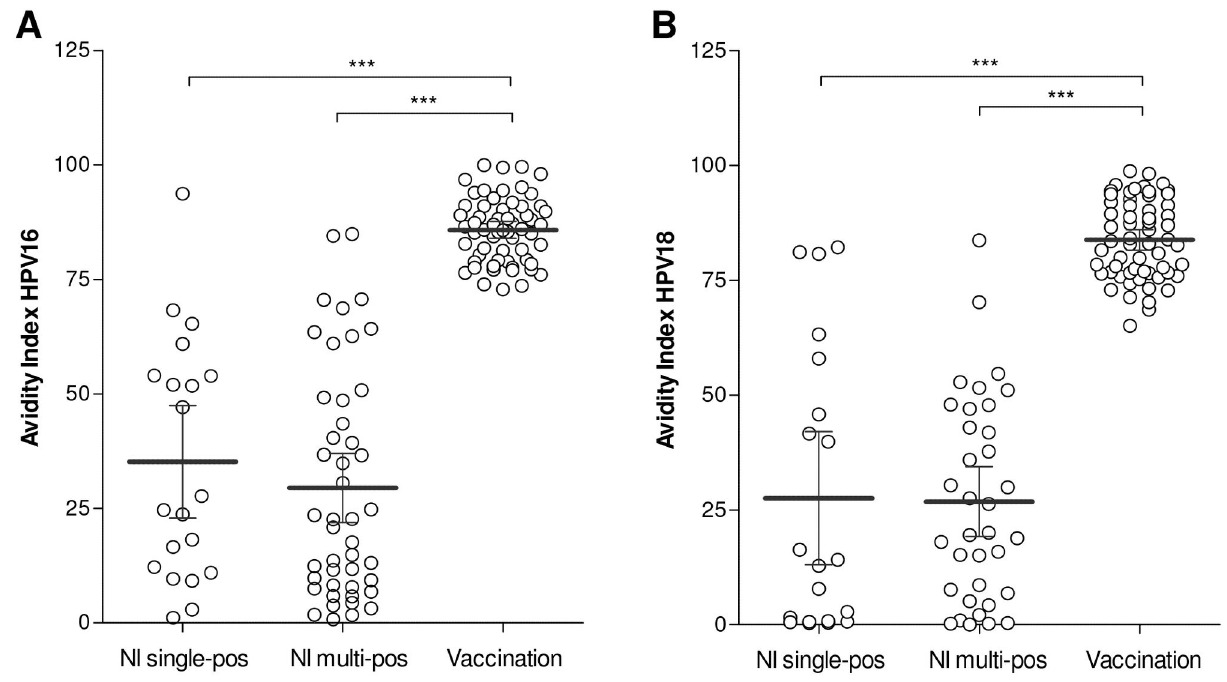
Figure 2. Antibody avidity after HPV infection and vaccination. Antibody avidity (%) for HPV16 (A) and HPV18 (B) of HPV- specific single-seropositive and multi-seropositive naturally derived antibodies and HPV vaccine-derived antibodies are shown. The dark grey line indicates the mean antibody avidity. *** p